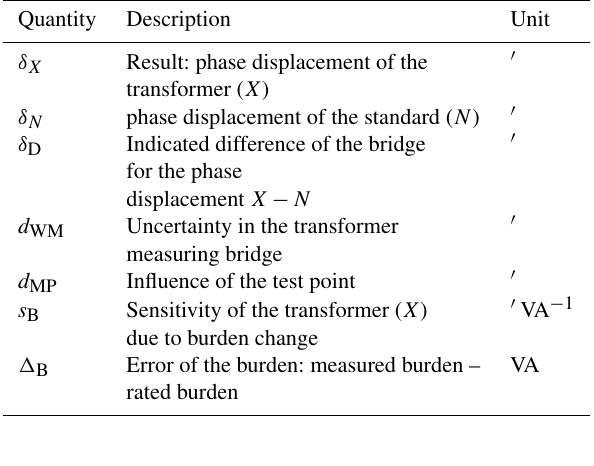
Table 3. Description of the symbols used.